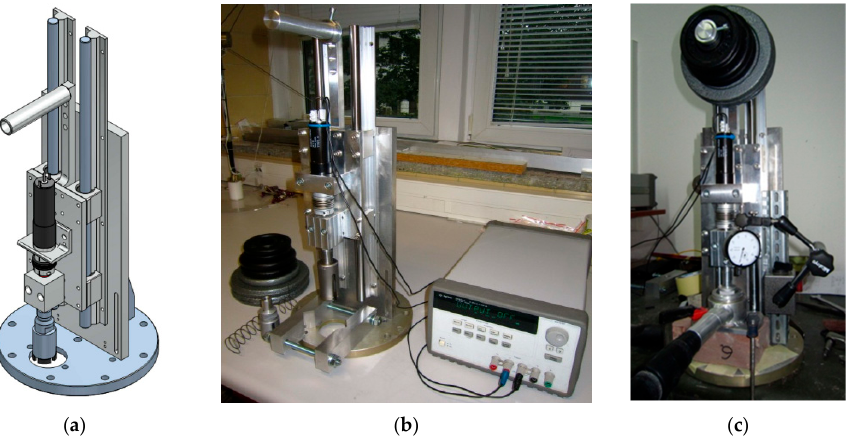
Figure 1. Drillability test stand: ( a ) 3D CAD model; ( b ) test stand with power supply and weights; ( c ) test stand during tests—dial indicator is used to measure drilling depth.